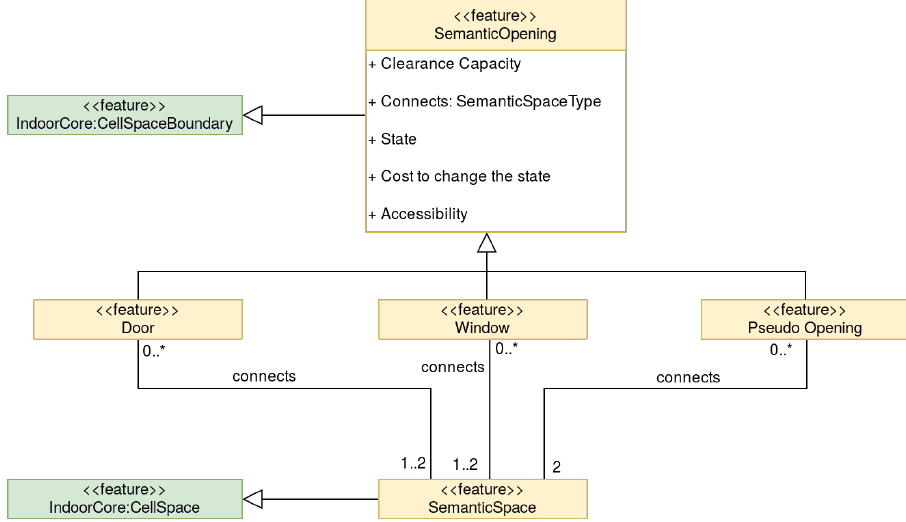
Figure 10. UML Class diagram of SemanticOpening showing its subtypes, its reference to CellSpaceBoundary from the existing IndoorGML core module and its relationship with SemanticSpace